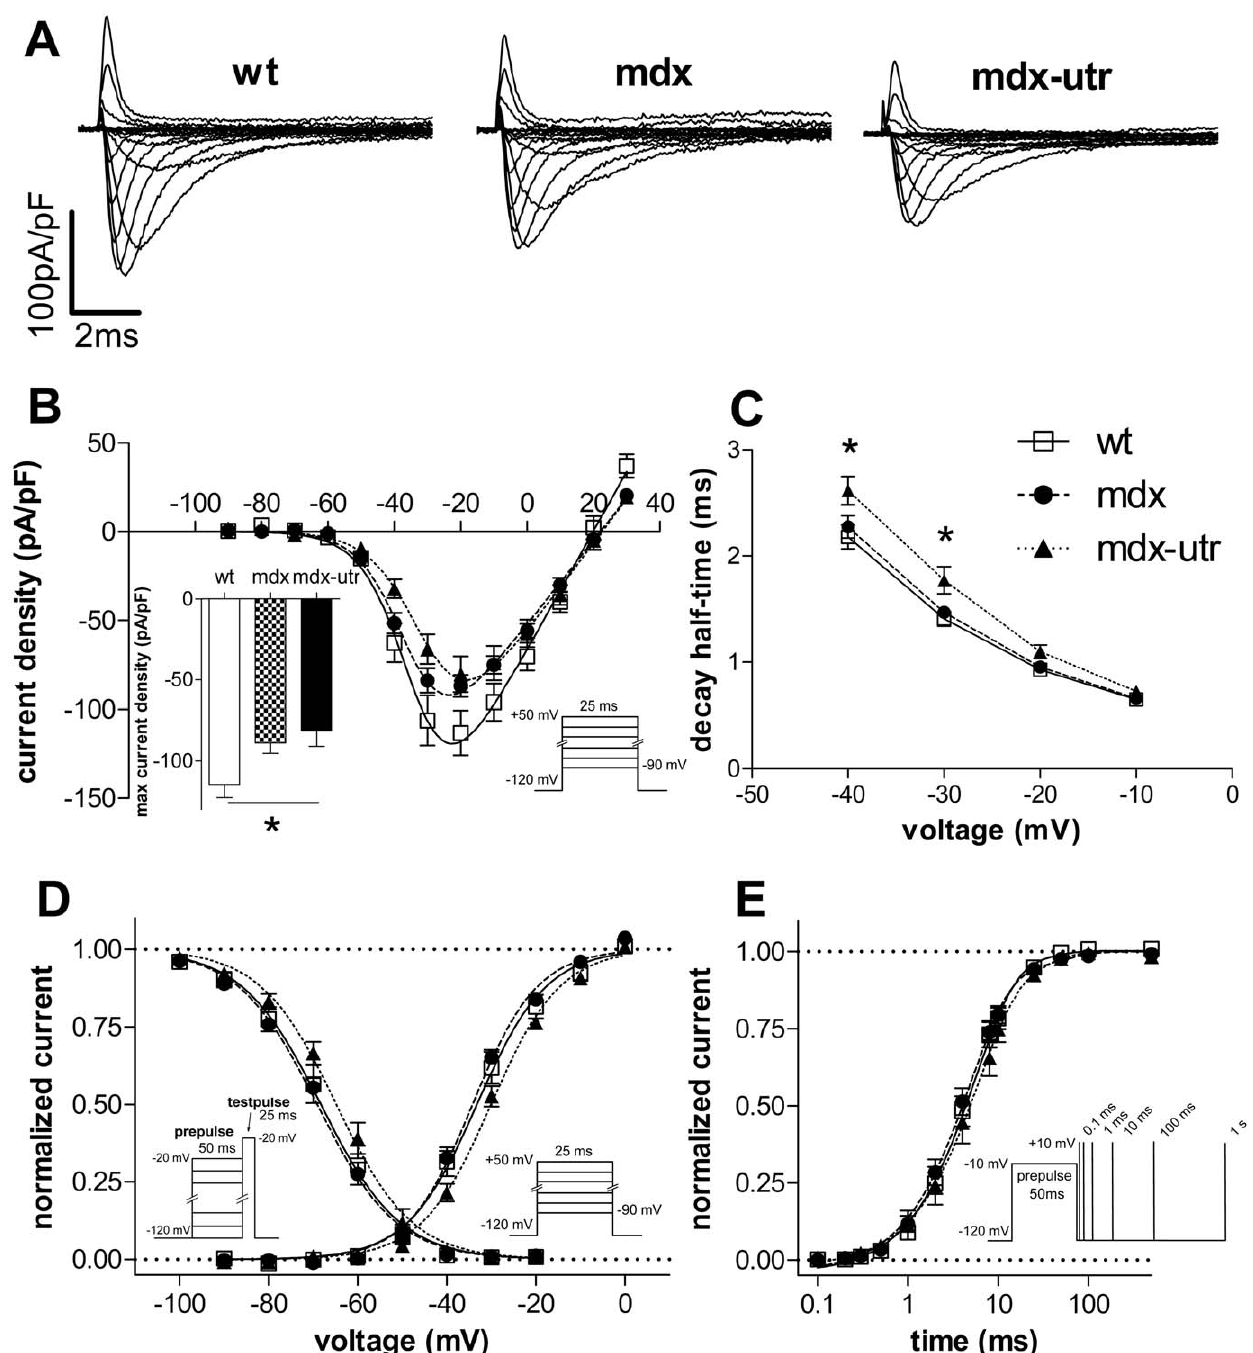
Figure 1. Sodium channel properties in wt and dystrophic neonatal cardiomyocytes. A. Original current traces of a typical wt, mdx, and mdx-utr cardiomyocyte, elicited by depolarising voltage-steps. B. Current-voltage relationships derived from a series of experiments as shown in A. The Inset (bar graph) shows a comparison of the maximum current densities between wt and dystrophic cardiomyocytes. C. Comparison of the current decay kinetics between wt and dystrophic cardiomyocytes at different membrane voltages. Decay half-times represent the time periods between the current peak and the time point at which the current had decayed to 50%. * indicates that ANOVA revealed a significant difference (p , 0.05) between the respective parameters of the three tested groups. Tukey’s Post Hoc test for comparison between two groups revealed significant differences (p , 0.05) between mdx-utr and wt, and between mdx-utr and mdx. D. Voltage-dependencies of activation and steady-state inactivation in wt and dystrophic cardiomyocytes. E. Recovery from inactivation in wt and dystrophic cardiomyocytes. Data were fit with a single exponential function. The pulse protocols are shown as insets in the respective graphs. Data points represent means 6 SEM. Detailed statistics and n-values are given in Table 1.